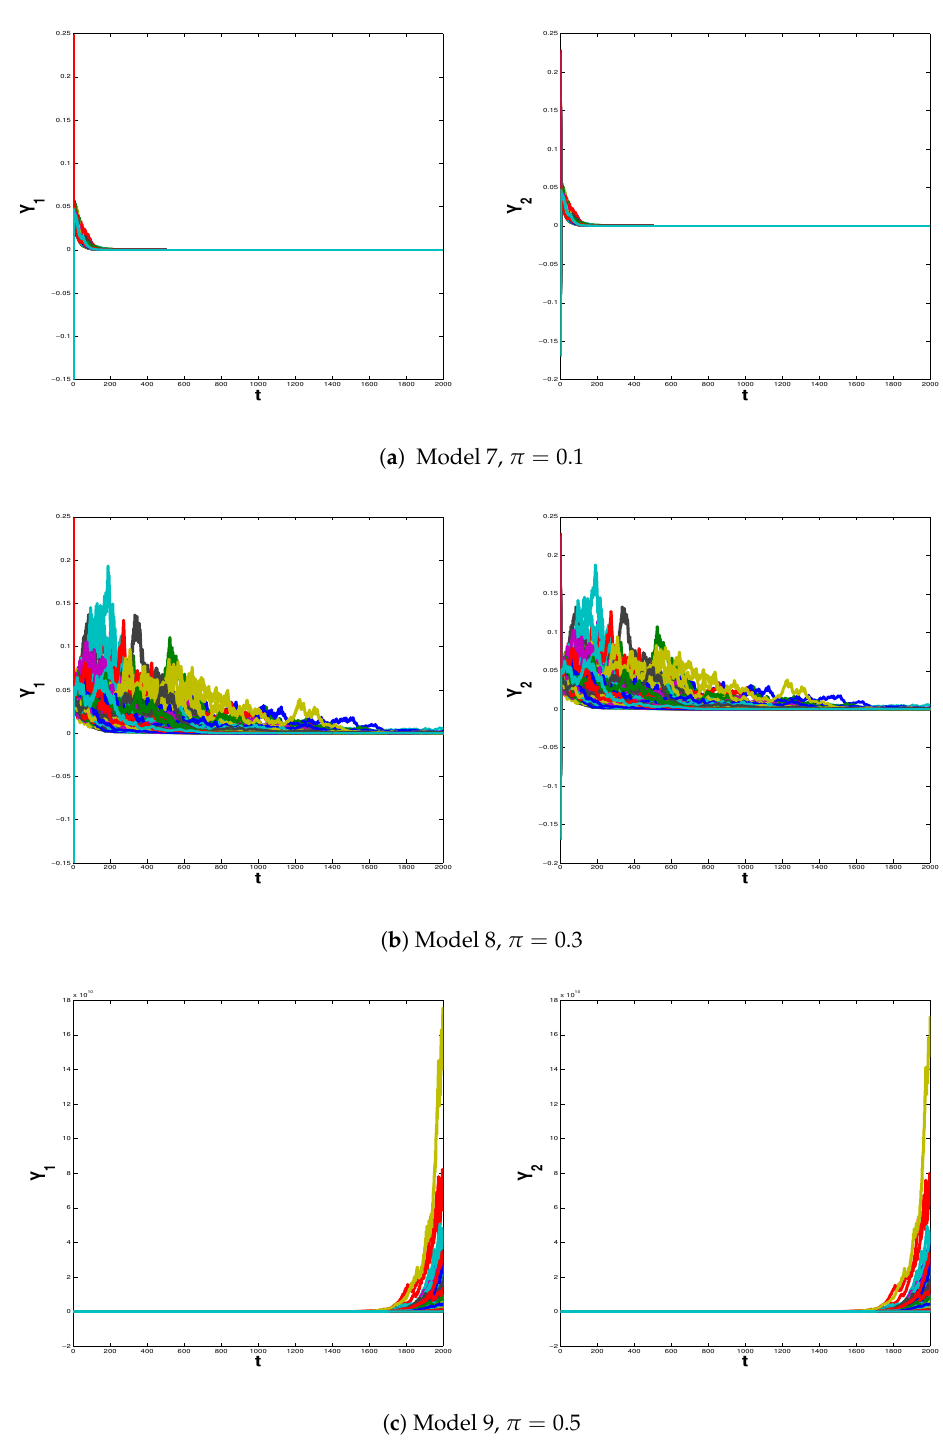
Figure A3. Simulated paths represented by different colors from models 7–9 for a different set of histories over a n = 2000 period using m = 200 simulated paths. The parameters are those from Table 1 and the probability to be in the explosive regime 2 is equal to π